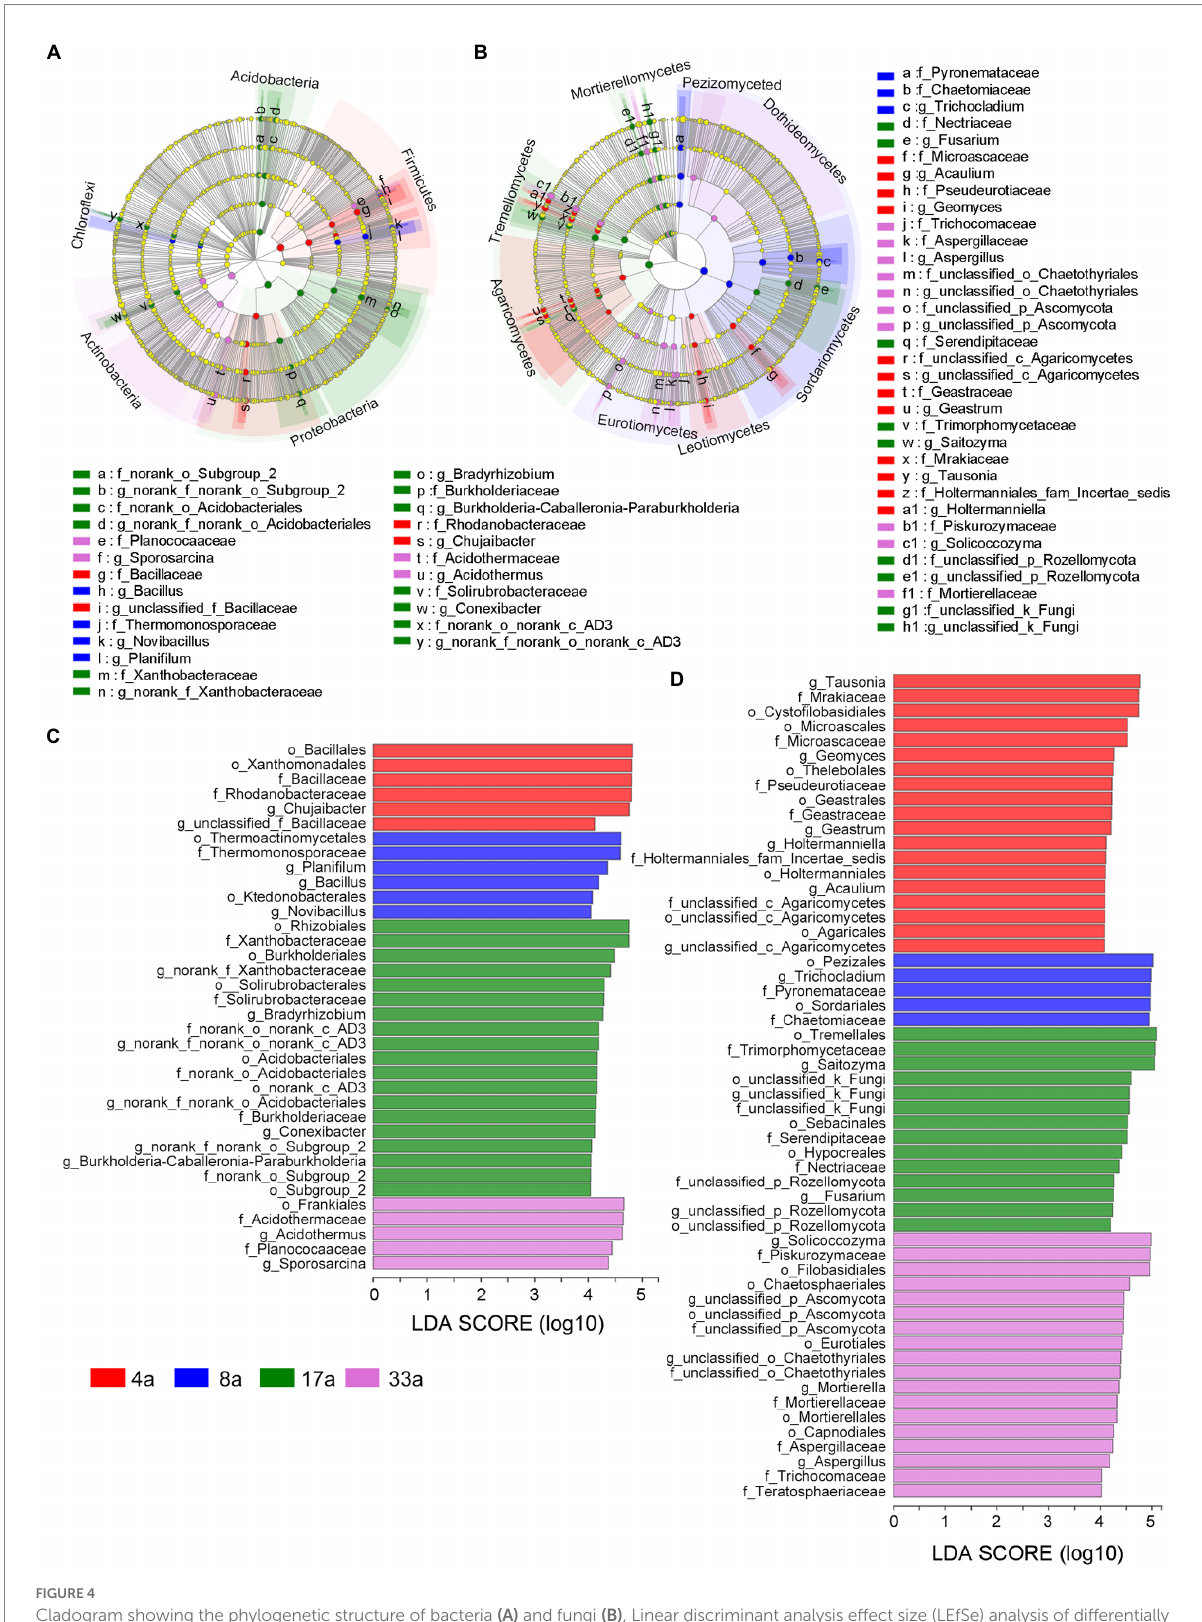
FIGURE 4 Cladogram showing the phylogenetic structure of bacteria (A) and fungi (B) , Linear discriminant analysis effect size (LEfSe) analysis of differentially abundant (LDA threshold score ≥ 4.0) orders, families, and genera of bacteria (C) and fungi (D) in the rhizosphere microbial communities of blueberries of different